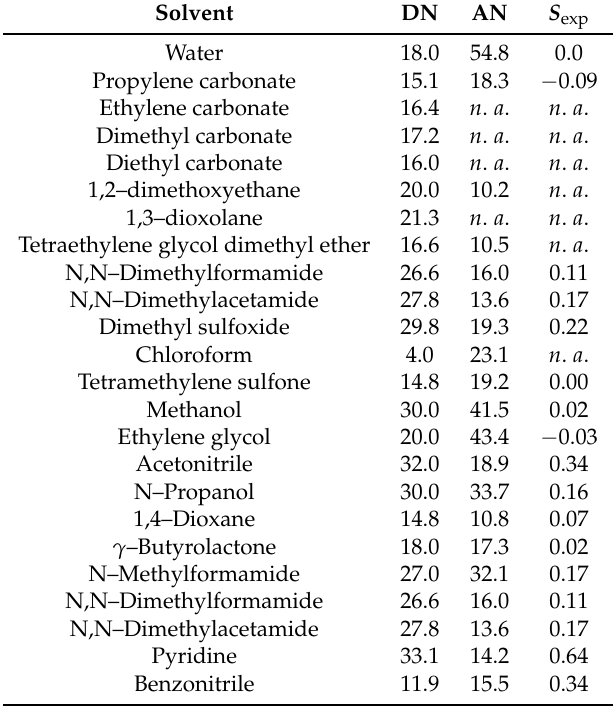
Table 1. Donor numbers (DN), acceptor numbers (AN), and values for the softness parameter ( S exp ) for common solvents according to Refs. [63,123–127]. Unknown values are denoted by n . a . Solvent DN AN S exp Water